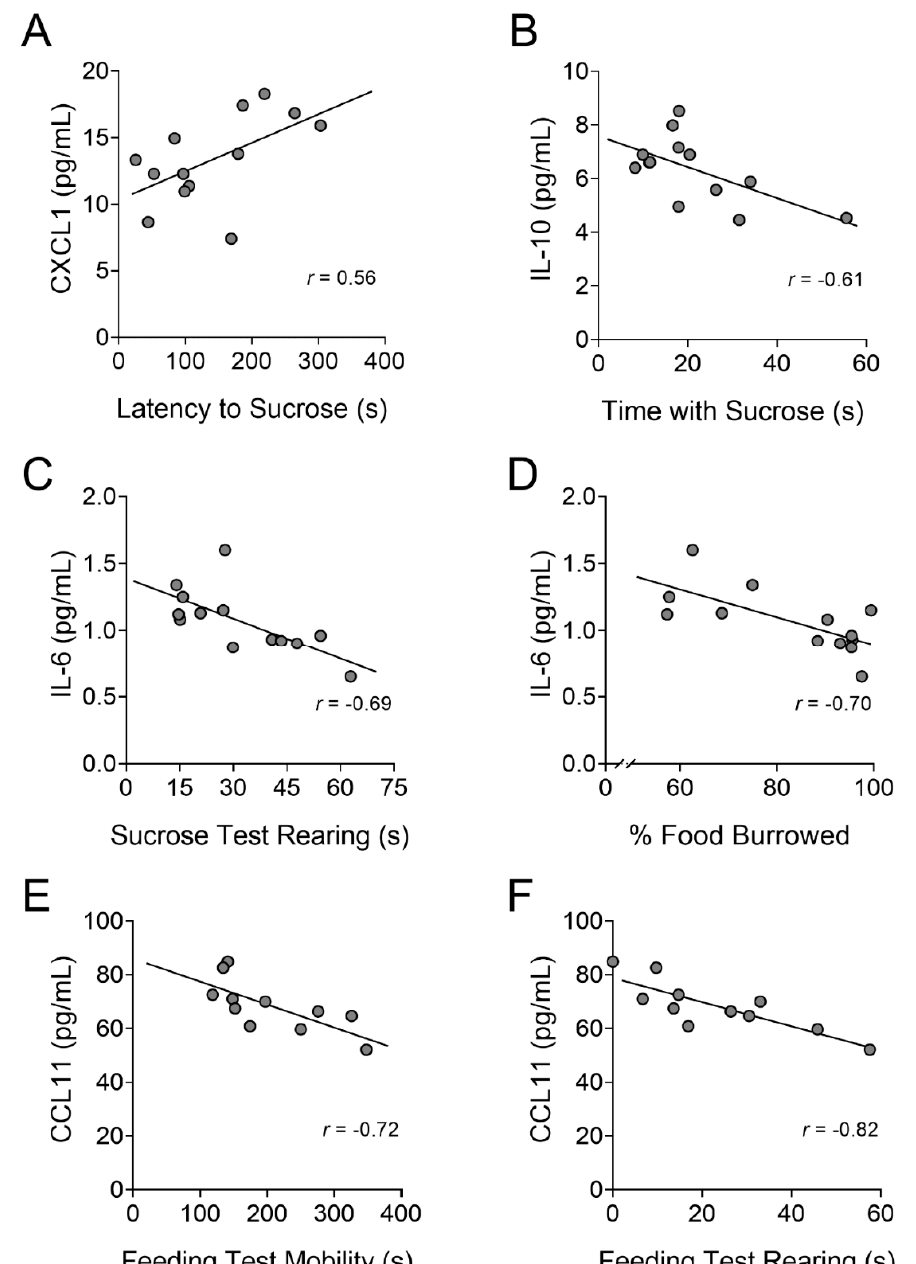
Figure 6. Increased PFC levels of CXCL1, CCL11, IL-6, and IL-10 positively correlated with depressive-like behavior and hypolocomotion. There was a direct correlation between increased levels of CXCL1 in the PFC and an increased latency to seek sucrose in the novelty-induced hypophagia test ( A ), whereas increased IL-10 expression inversely correlated with sucrose consumption ( B ). Increased levels of the proinflammatory cytokine IL-6 in the PFC negatively correlated with the time spent rearing in the novelty-induced hypophagia test ( C ) and the percentage of food burrowed in the burrowing test of well-being ( D ). There was also an inverse correlation between CCL11 and mobility ( E ) and rearing ( F ) in the novelty-suppressed feeding test. Correlation coefficient z -tests were performed with hypothesized correlations equal to 0. After false discovery rate (FDR) corrections for performing multiple z tests were applied, only the inverse correlation between CCL11 PFC levels and rearing behavior in the novelty-suppressed feeding test was significant; n = 11–13 mice per group.